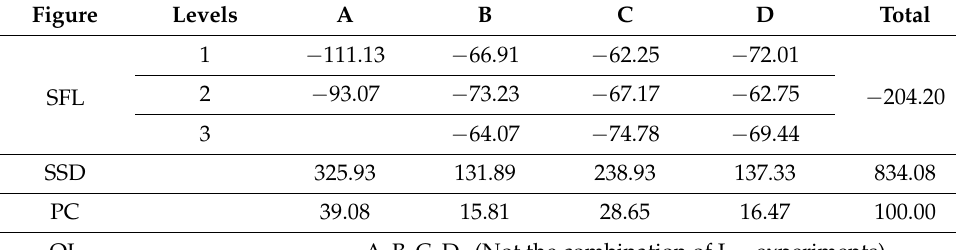
Table 9. Pareto ANOVA results for surface roughness (SR).